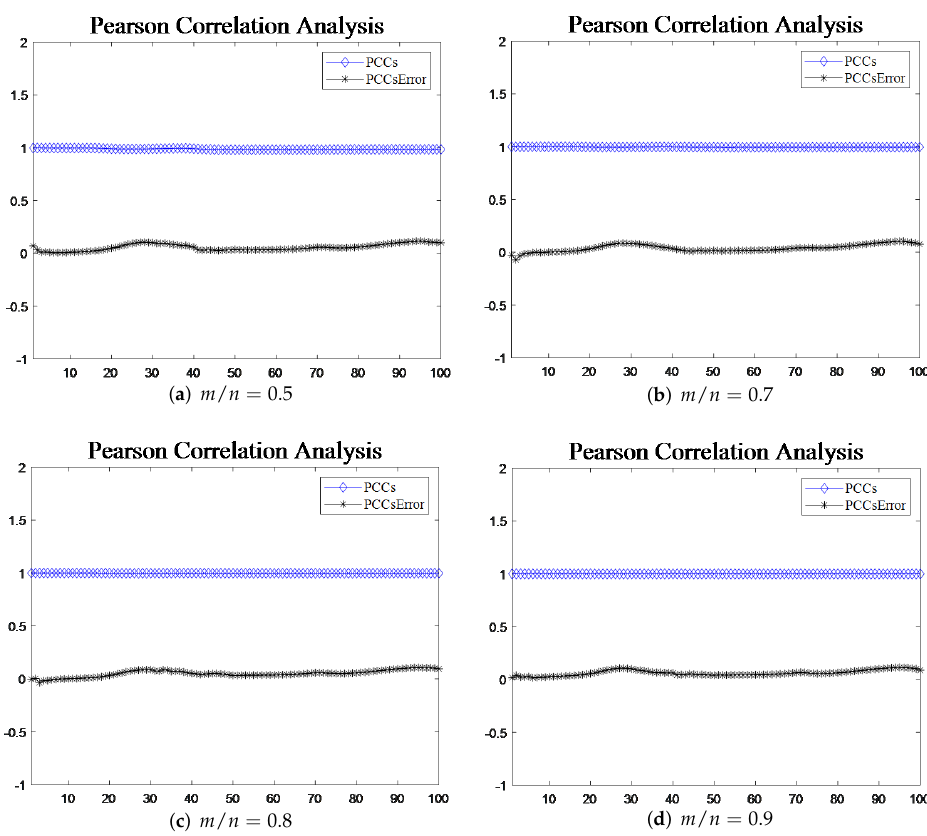
Figure 6. ( a ) Comparison of PCCs and PCCsError under m / n = 0.5. ( b ) Comparison of PCCs and PCCsError under m / n = 0.7. ( c ) Comparison of PCCs and PCCsError under m / n = 0.8. ( d ) Comparison of PCCs and PCCsError under m / n = 0.9.